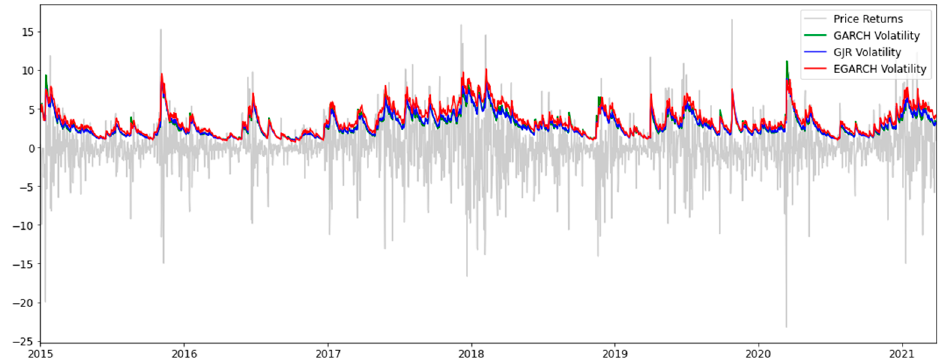
Figure 4. Bitcoin ( a ) daily closing prices, ( b ) log-returns, ( c ) squared log-returns, and ( d ) realized volatility from 1 January 2015 to 31 March 2021.